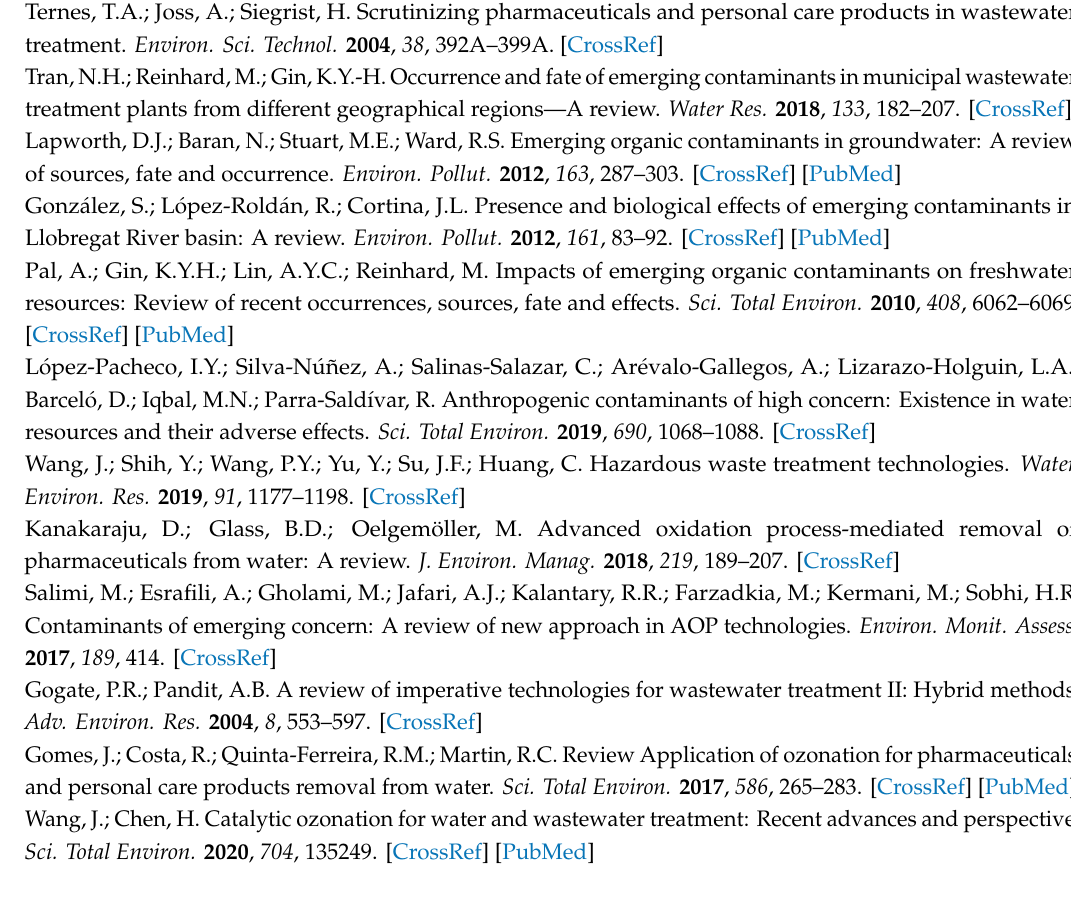
Figure S6. Experimental vs predicted values of TOC and C O3g in Ozonation for the first reaction period. Dotted lines correspond to ± 10% deviations. Figure S7. Experimental vs. predicted values of TOC and C O3g in PhCatOz for the first reaction period. Dotted lines correspond to ± 10% deviations. Figure S8. Experimental vs. predicted values of TOC and C O3g in Ozonation for the second reaction period. Dotted lines correspond to ± 10% deviations. Figure S9. Experimental vs. predicted values of TOC and C O3g in PhCatOz for the second reaction period. Dotted lines correspond to ± 10% deviations. Figure S10. XRD of GO / TiO 2 composite. Table S1. ANOVA statistics of the kinetic model at 0.05 significance level for the first reaction period. Table S2: ANOVA statistics of the kinetic model at 0.05 significance level for the second reaction